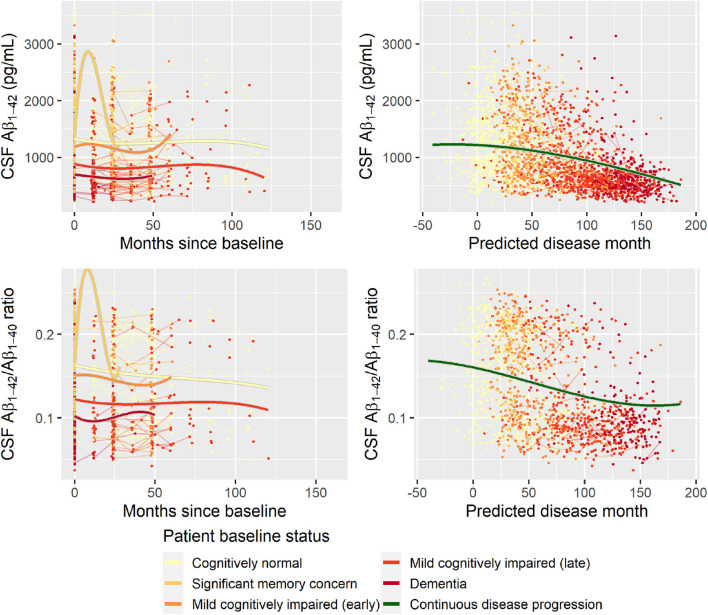
Data and estimated biomarker trajectories for Aβ1−42 (CSF) and Aβ1−42/Aβ1−40 ratio (CSF). Left column shows results when allowing different trajectories for the five baseline groups; right column shows the results when requiring a single trajectory over predicted disease time. Note that the oscillations for the significant memory concern group occur in time periods where no data were collected for this group.